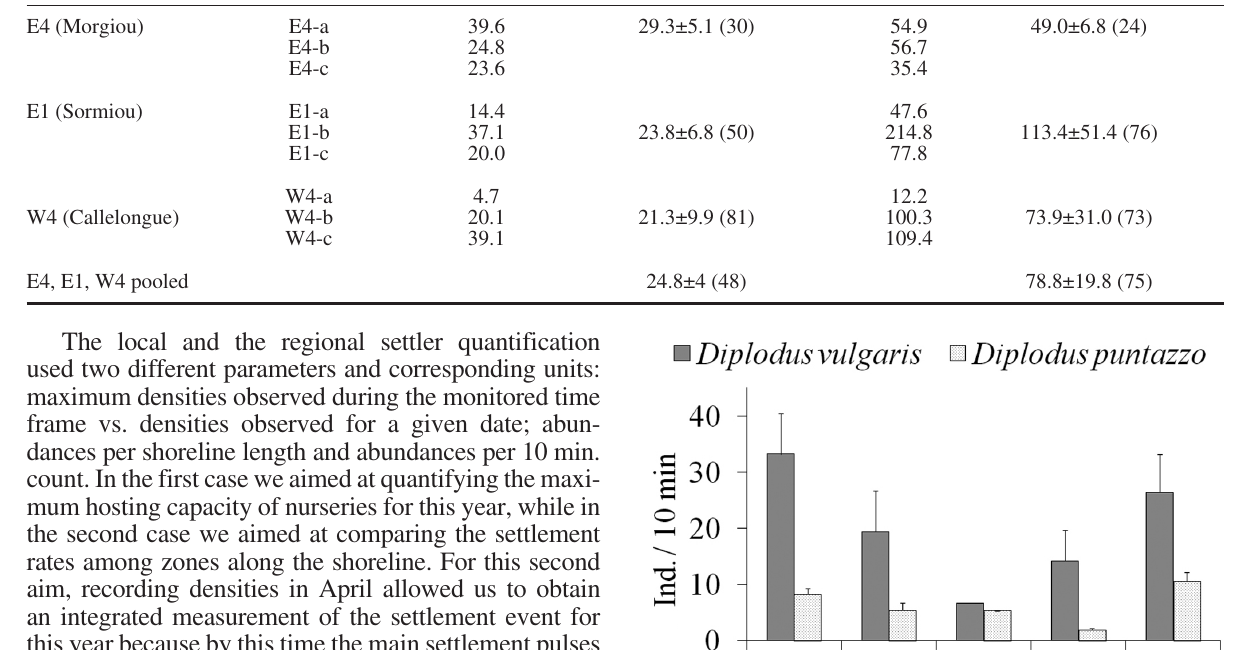
Table 1. – Maximum densities of settlers observed for Diplodus puntazzo and Diplodus vulgaris in the monitored nursery replicates (ind./100 m) and means within the local scale study sites (Calanques); SE, Standard error; CV, coefficient of variation. Site (Calanque)